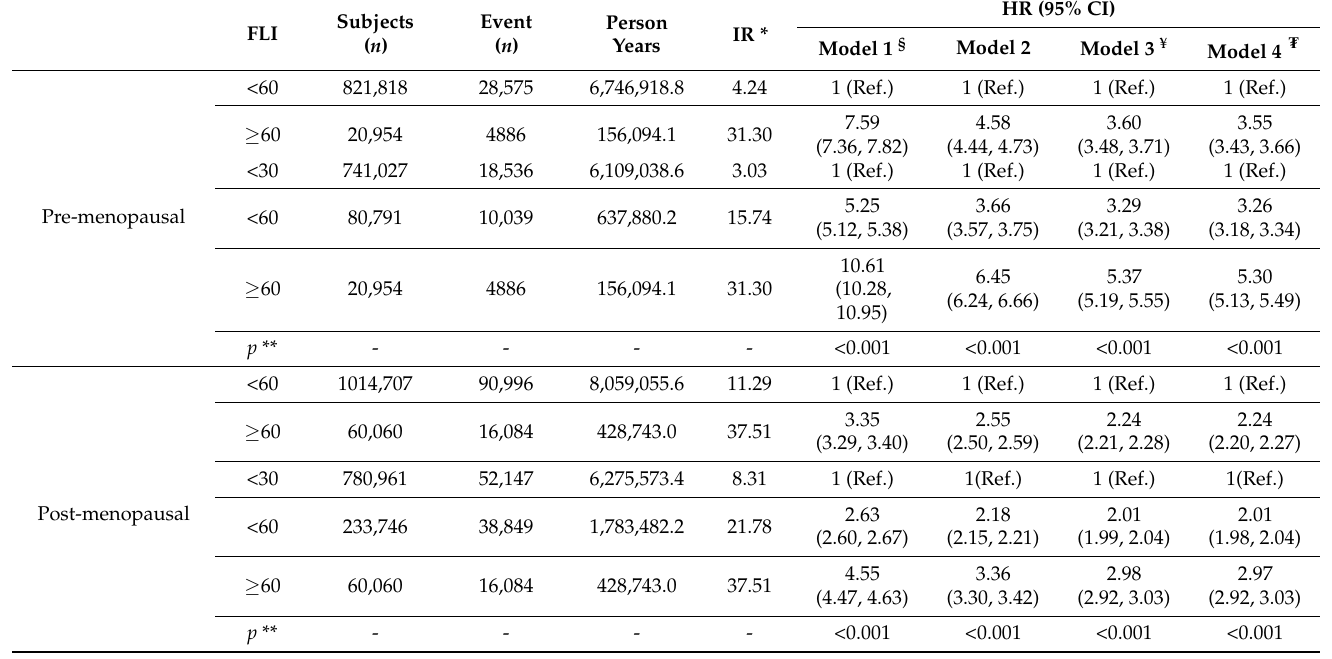
Table 3. Associations between fatty liver index and type 2 diabetes mellitus risk by menopausal status.